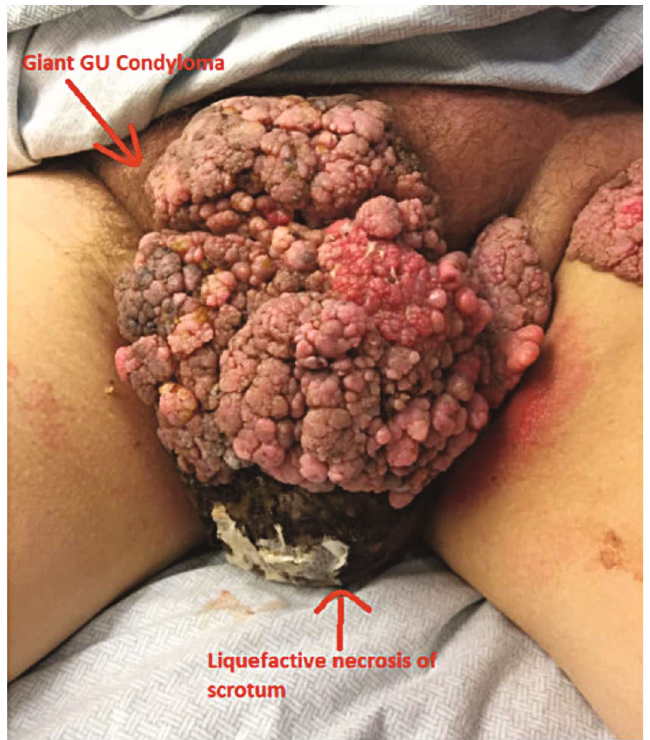
Figure 3: A patient ’ s presentation with giant GU condyloma and liquefactive necrosis of the scrotum.